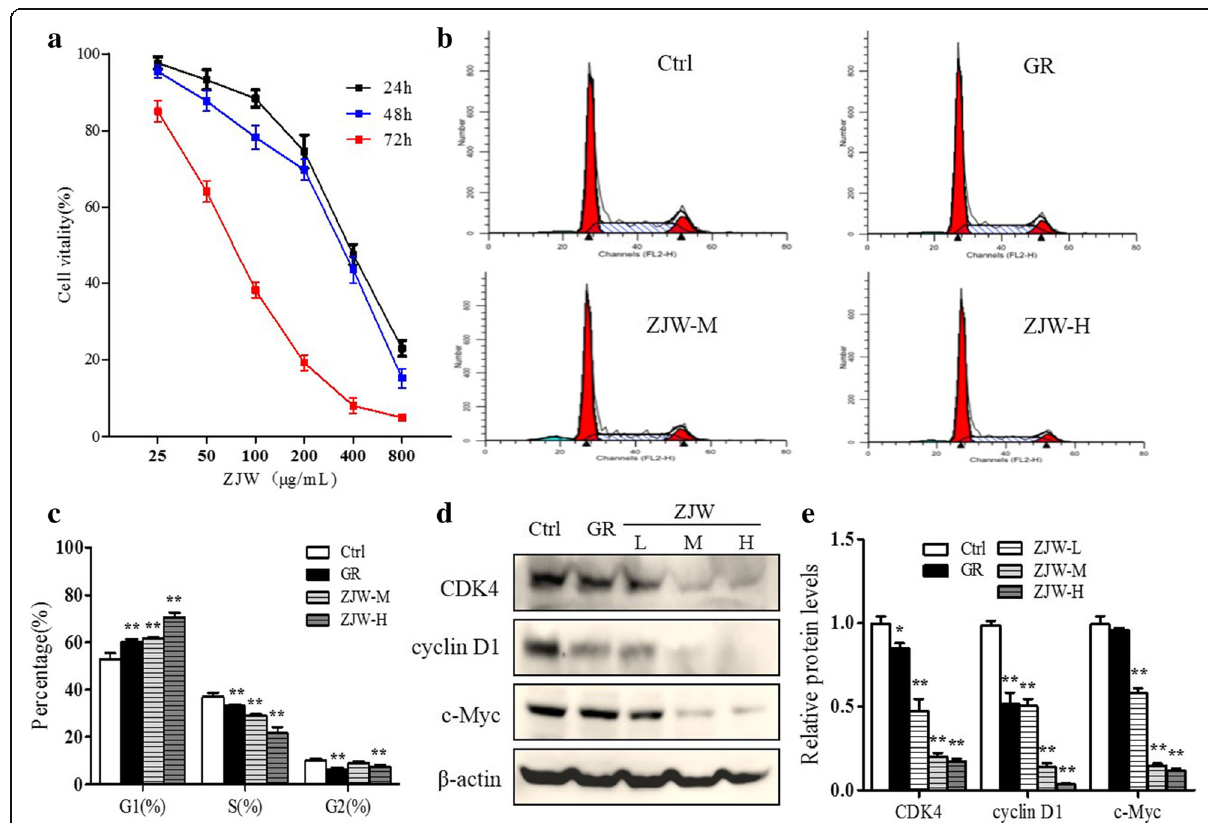
Fig. 2 Effect of the ZJW extracts treatment on SW403 cell proliferation. a Cell proliferation was determined using the CCK8 assay. The total viability of cells treated with ZJW (25, 50, 100, 200, 400 and 800 μ g/mL) for 24, 48 and 72 h were measured. b and c The percentage of cells at G1, S, G2 phase after treatment with GR (5 μ mol/L), ZJW-M or ZJW-H for 24 h. d Representative western blots of CDK4, cyclin D1 and c-Myc in SW403 cells treated with GR (5 μ mol/L), ZJW-L, ZJW-M or ZJW-H. e The corresponding semi-quantification data of d . All values are shown as mean ± SD of three separate experiments, and significant values are indicated with asterisks (* P < 0.05, ** P < 0.01 vs.